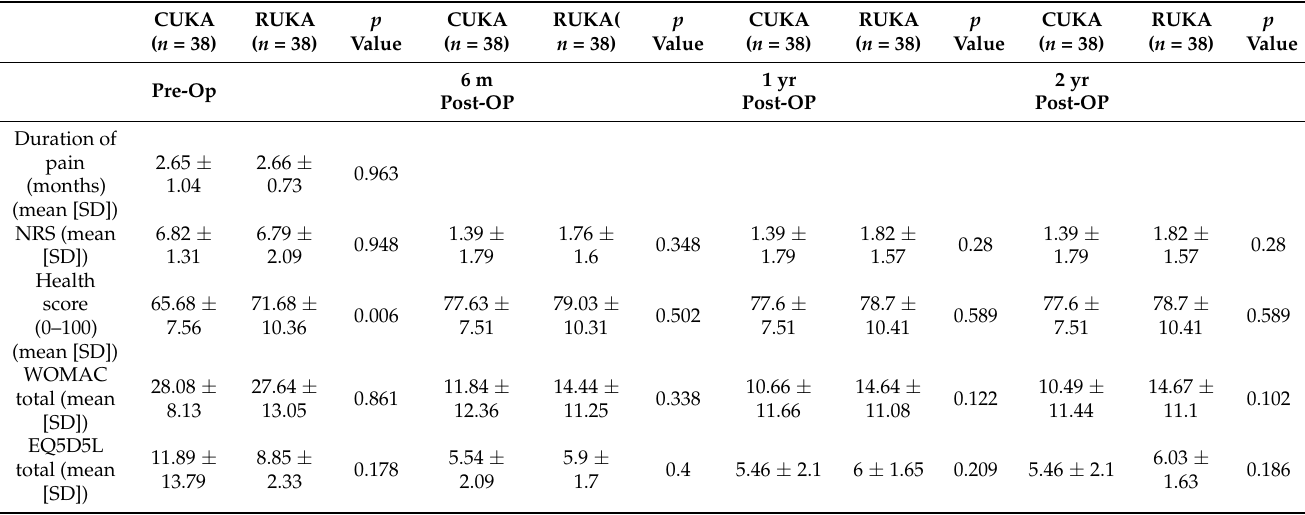
Table 3. Follow-up preoperative and postoperative NRS, health, WOMAC, and EQ5D5L scores at 6 months, 1 year, and 2